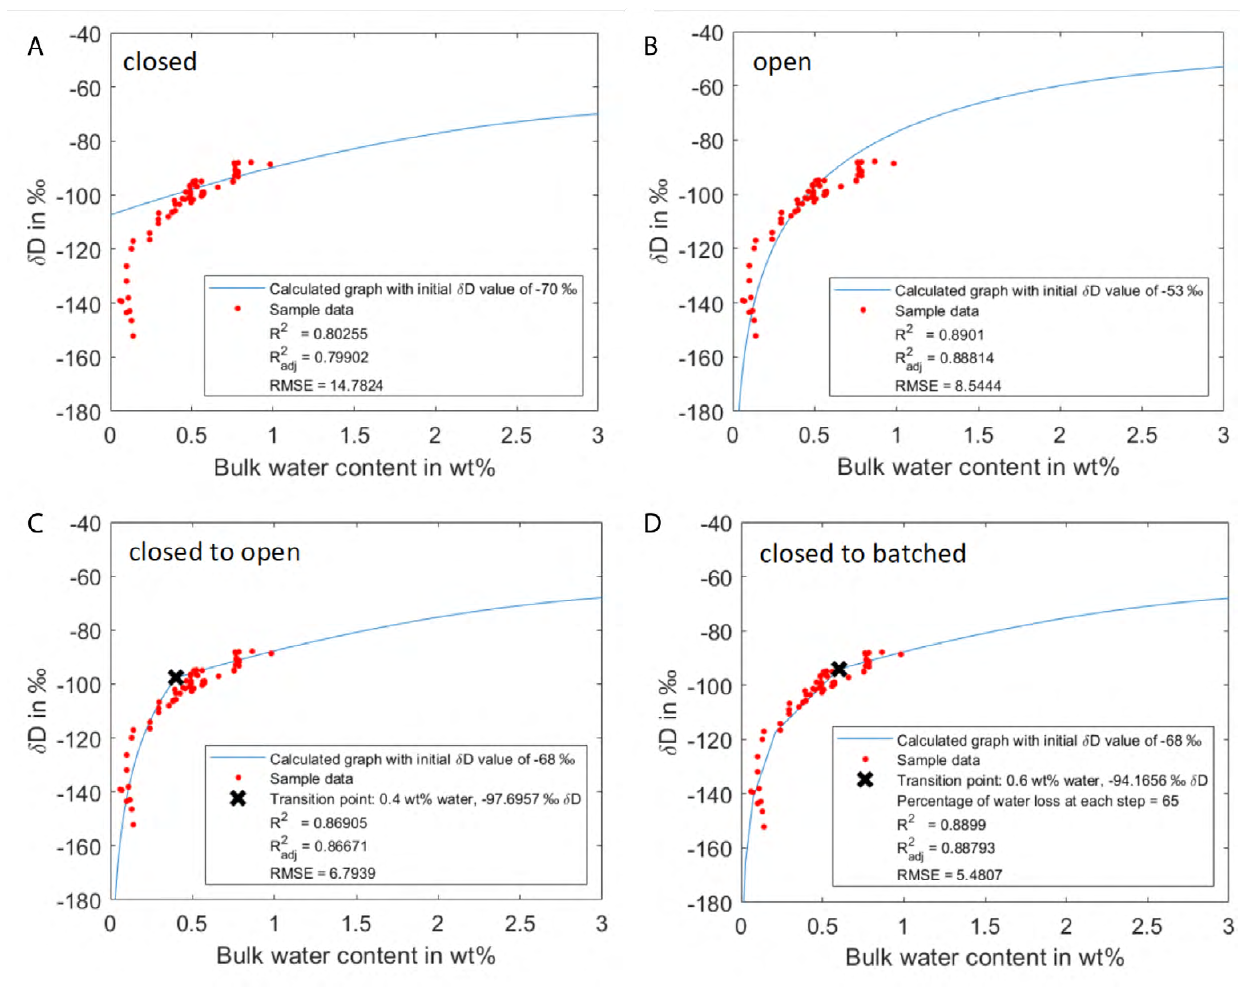
Figure 6: Best-fit VolcDeGas degassing simulations (blue curves) of measured δ D–H 2 O data (dots) from pyroclastic and effusive obsidians from Big Glass Mountain. VolcDeGas iteratively determines the best-fit path based on initial ) and H O content, hydrous speciation calculations, variable degassing step size, and a degassing mode δ D (in o { 2 oo transition point (in the case of two-stage and batched degassing, frames [C] and [D], respectively). The best-fit parameters are shown in the figure insets along with statistical model errors. All simulations start at 3.0 wt.% H Lava data points (at lowest H O, <0.2 wt.%) are measurements made by DeGroat-Nelson et al. [2001]. Frames [A] 2 and [B] show single-stage, end-member closed- and open-system degassing paths, which appear to only partially fit the high- and low-H O content segments of data, whereas frames [C] and [D] indicate best fit models 2